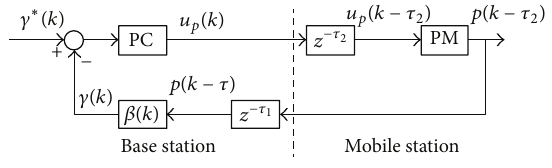
Figure 1: Time delays in power